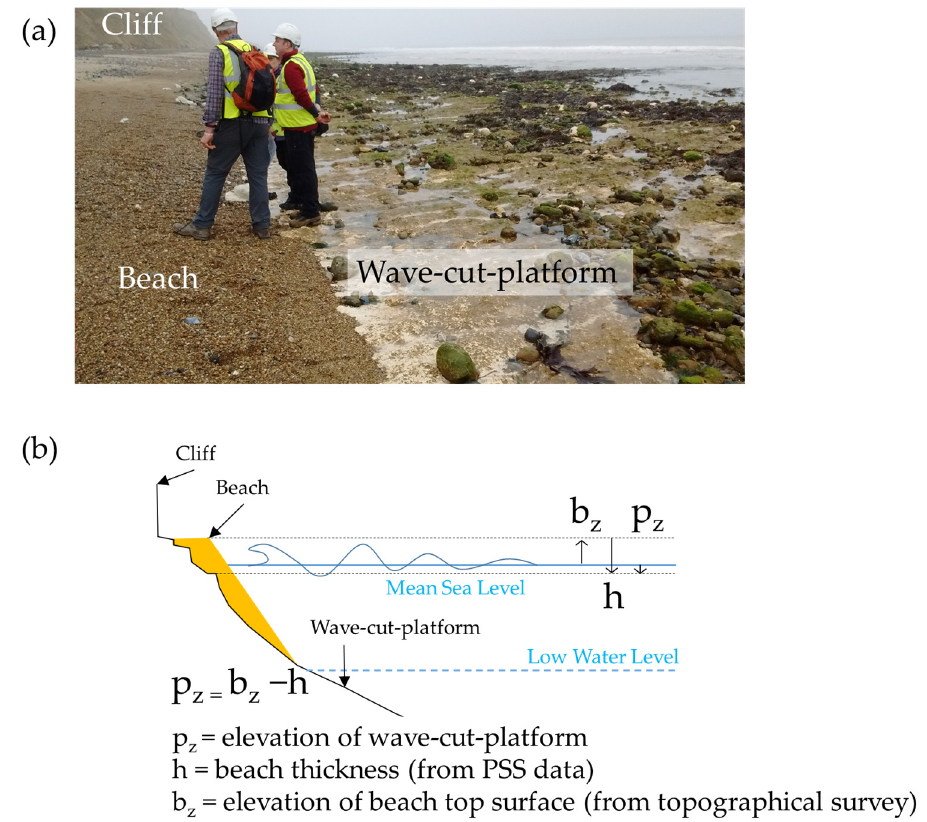
Figure 1. Wave-cut platforms are often covered by beach deposits and its position can be obtained from beach thickness and beach elevation: ( a ) photo taken near Trimingham, East England showing a cliff, beach, and wave-cut platform (source BGS); ( b ) schematic showing how wave-cut platform elevation can be obtained from beach thickness and beach elevation observation.